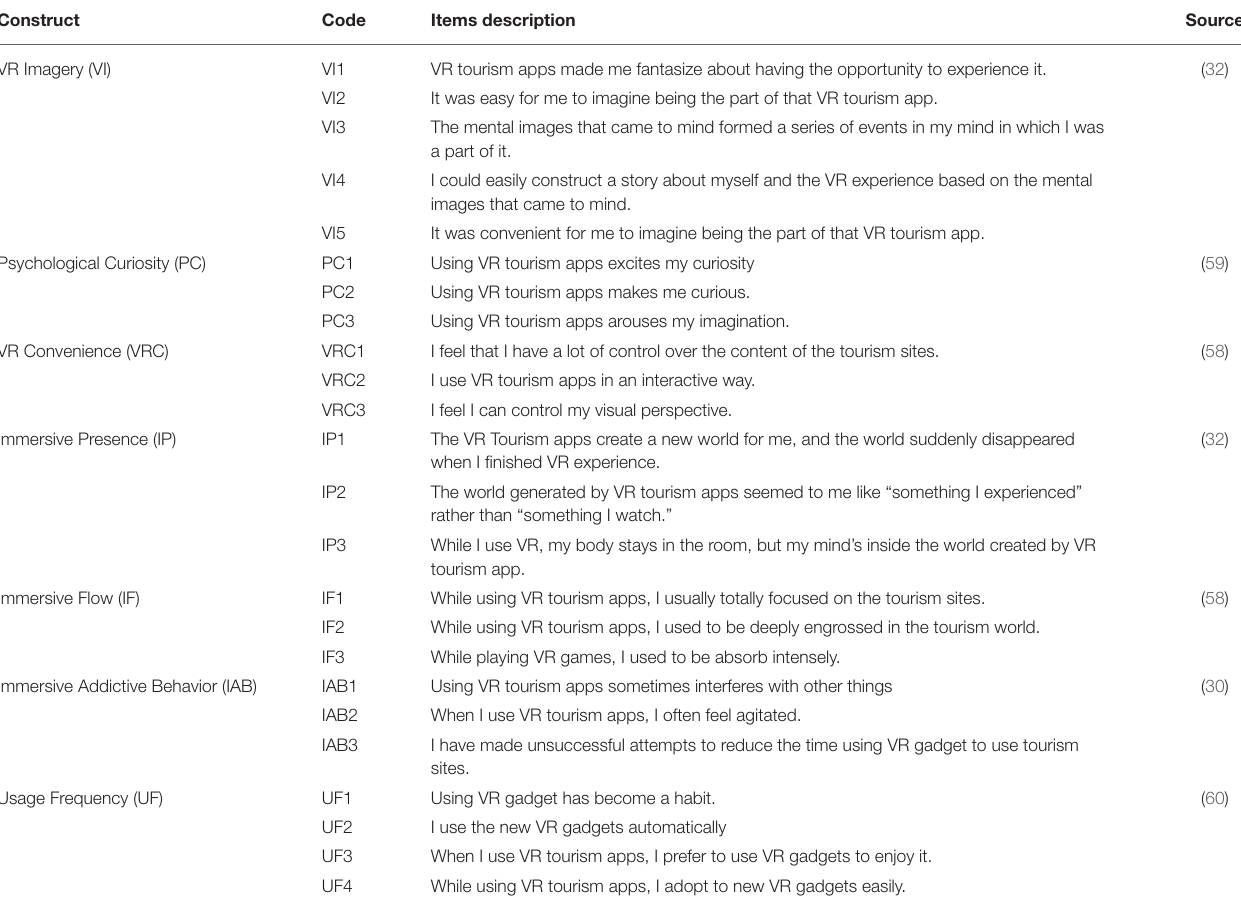
TABLE 1 | Constructs, instruments, and sources. Construct Code Items